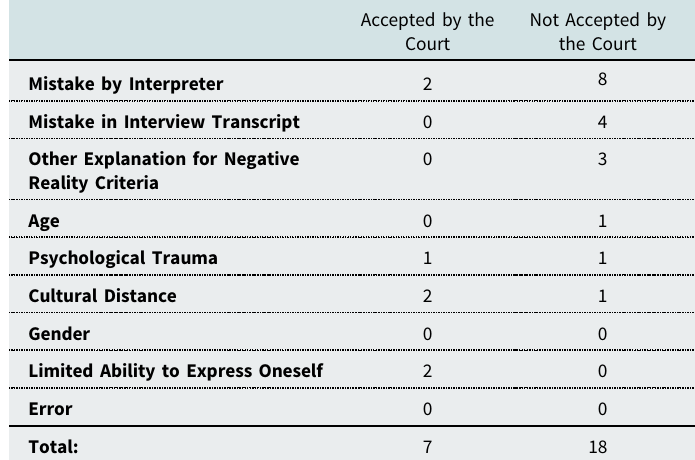
Table 6. Confounding